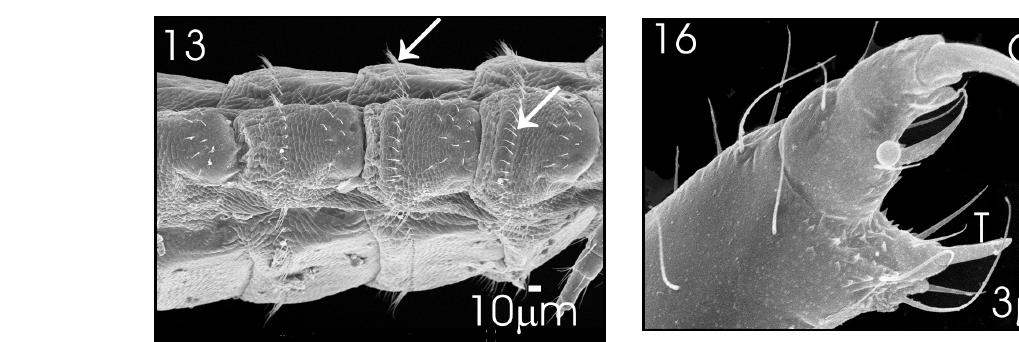
Fig. 16. The legs terminated in a claw (C) that closed against an appositional distio-tibial thumb- like seta